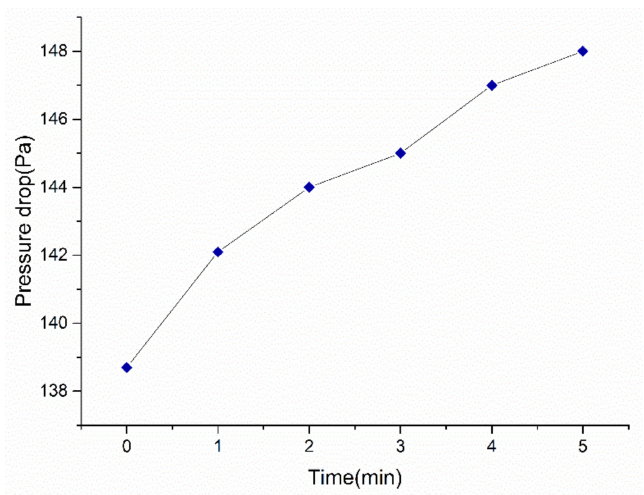
Figure 13. Variation of wet air flow rate after frosting.